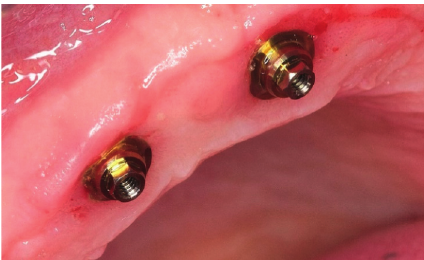
Figure 22: Formation of the emergence profile around the removable multiunit base.